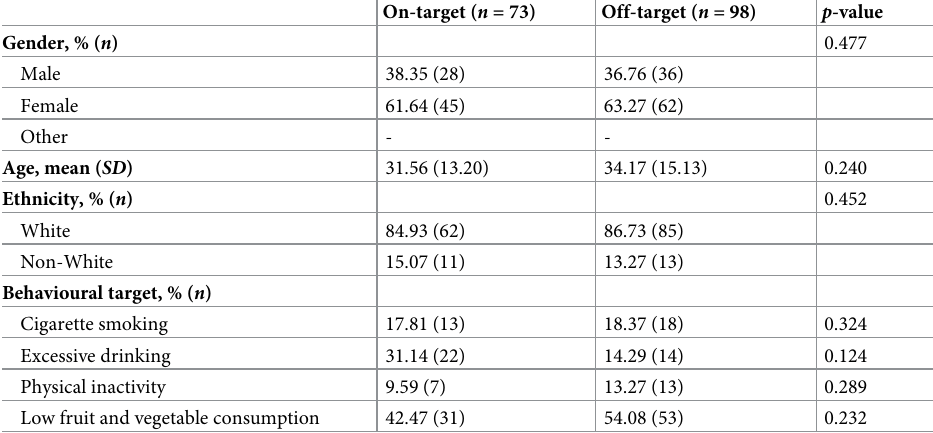
Table 4. Participant characteristics by group allocation (n =